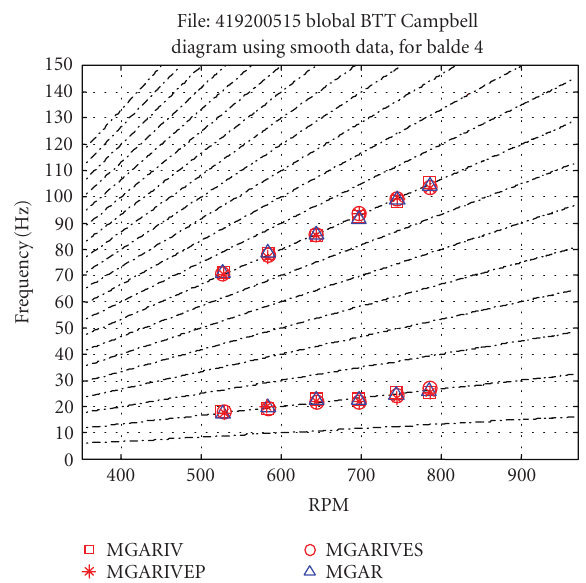
Figure 10: Double resonance case: Campbell diagram constructed from multidegree of freedom BTT analysis.